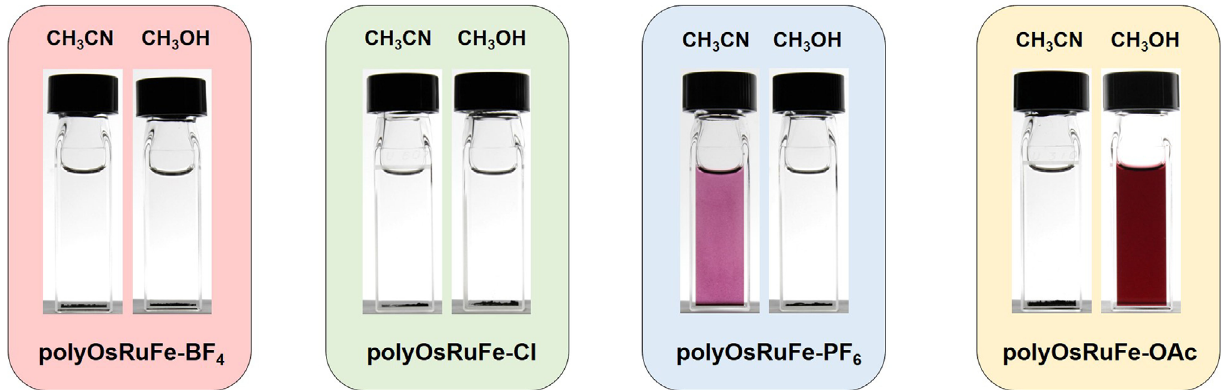
Fig. 7 Observed solubility of polyOsRuFe-A (A: BF 4 , Cl, PF 6 , and OAc) in CH 3 CN and CH 3 OH. The observed solubility of polyOsRuFe-BF 4 , polyOsRuFe- Cl, polyOsRuFe-PF 6 , and polyOsRuFe-OAc in CH 3 CN and CH 3 OH. Besides CH 3 OH, the polyOsRuFe-OAc was also soluble in EtOH and H